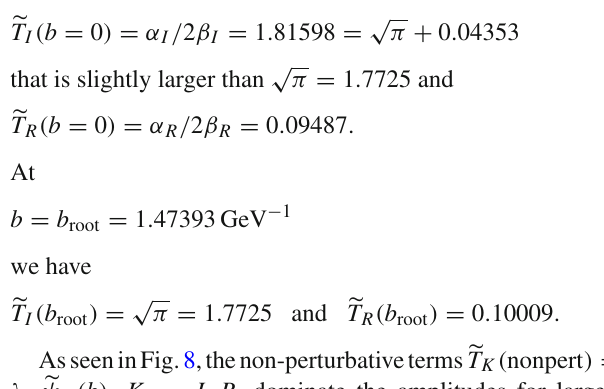
proton form factor. We recall that in the detailed analysis of forward data studying the influence of the CNI phase [4], reported values are σ = 111 . 84mb , ρ = 0 . 125for φ = 0,and σ = 111 . 84mb , ρ = 0 .